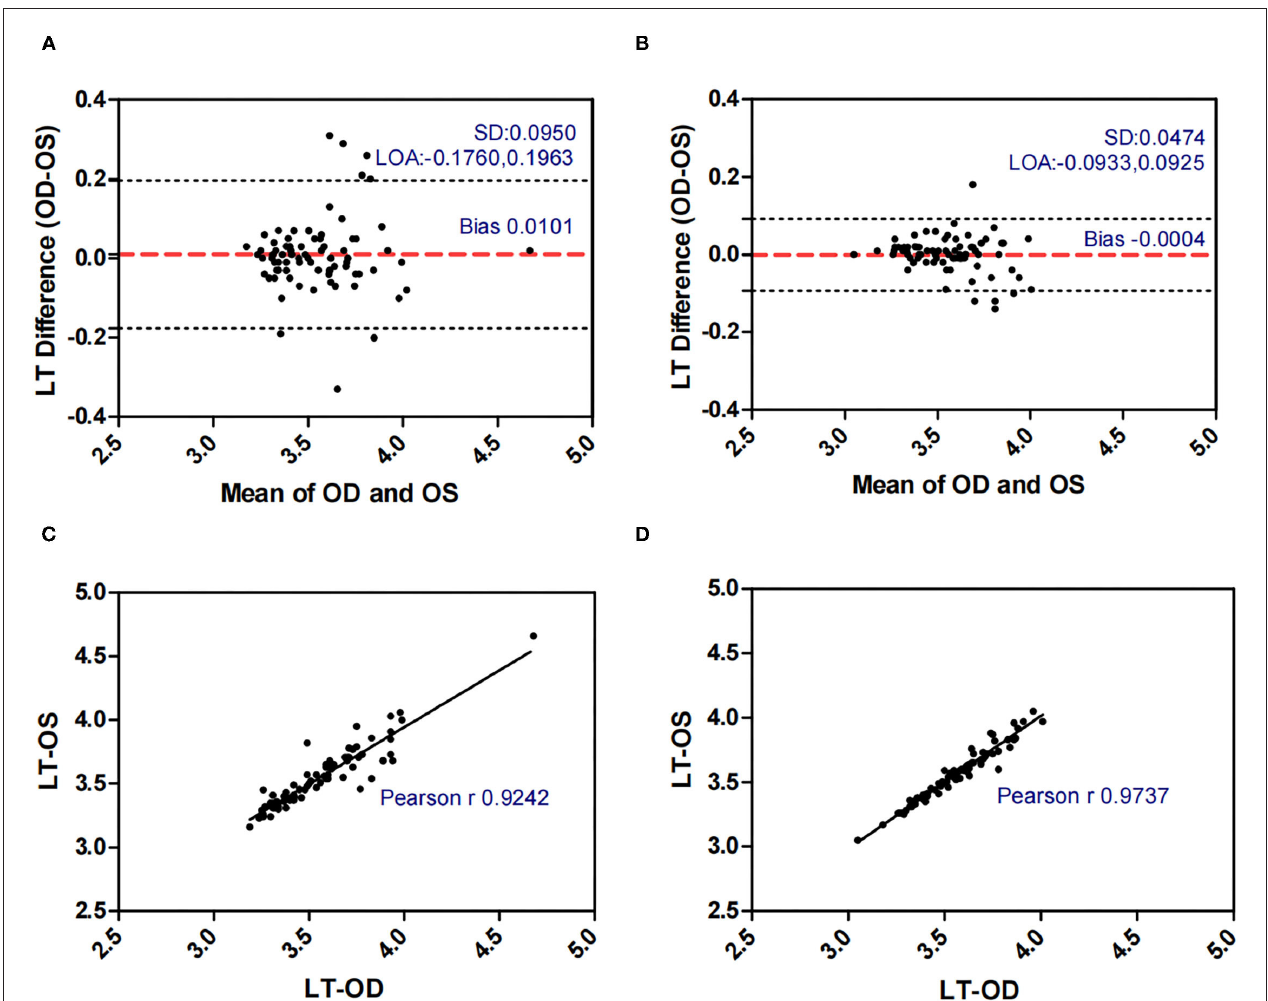
FIGURE 5 | Bland-Altman plots (A,B) and scatter plots (C,D) of LT in concomitant exotropia (A,C) and normal control participants (B,D) of the left and right eyes. OS, left eye; OD, right eye; LT, lens thickness; LOA, 95% limits of